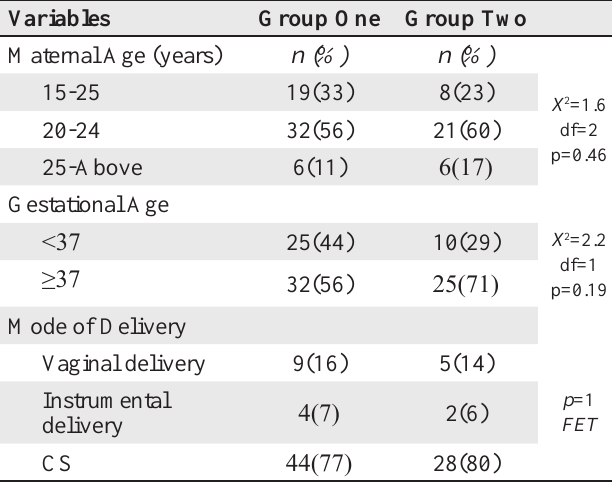
Table 1 .Distribution of characteristics of eclamptic